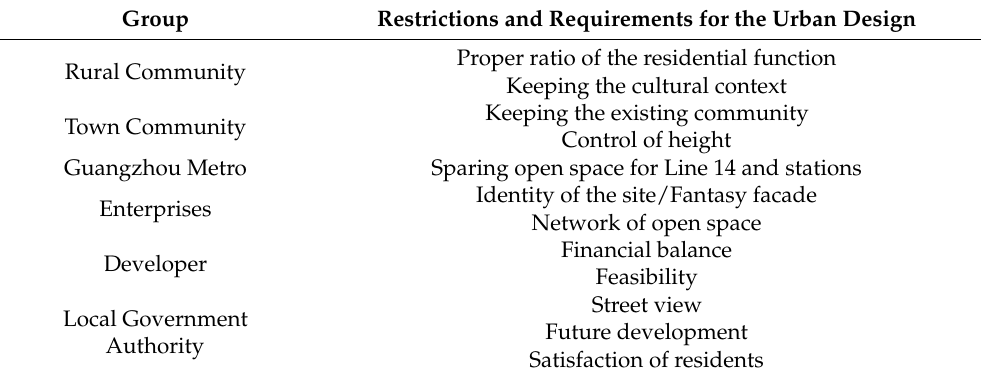
Table 1. Restrictions and requirements of different groups of stakeholders in the H-Village project.